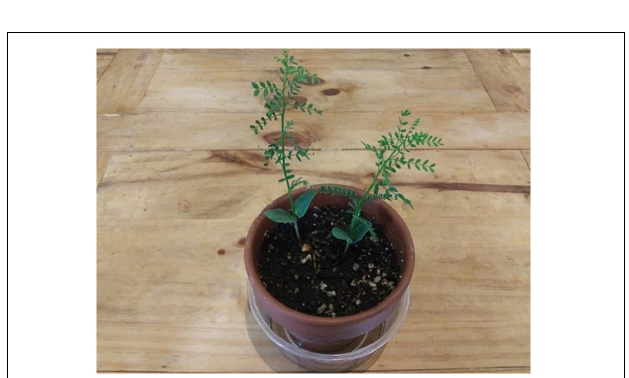
FIGURE 6 | Examples of P. microphylla seedlings derived from the treatment group (snake gut transit) in the primary study involving Western Diamond-backed Rattlesnakes ( C. atrox